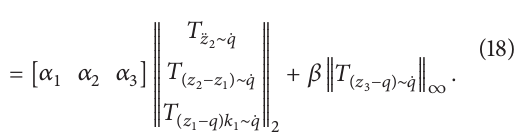
Figure 8: RMS map of dynamic